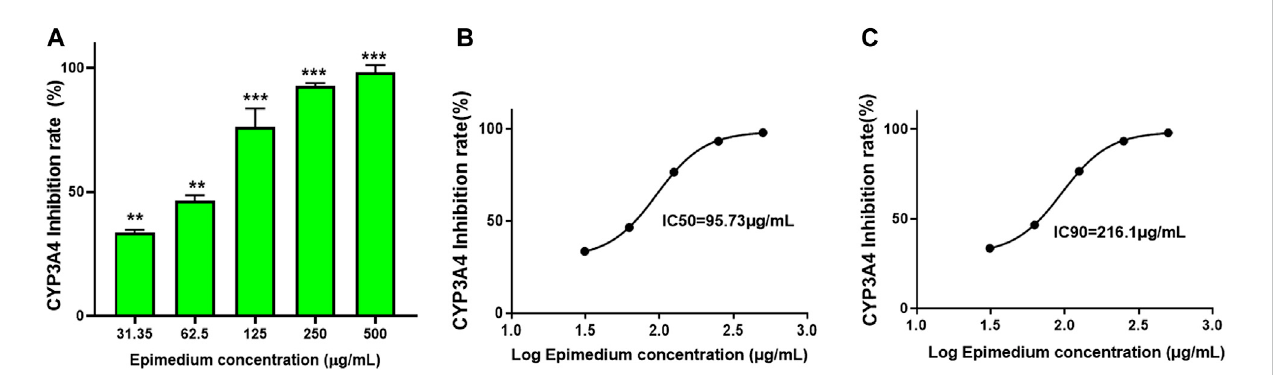
FIGURE 1 Epimedium inhibition of CYP3A4 activity: The inhibition of CYP3A4 was measured by commercially available Vivid assay kit as per manufacturers instruction. Epimedium showed dose-dependent suppression of CYP3A4 enzyme activity (A) . The IC 50 and IC 90 were calculated to be 95.73 pg/mL and 216.1 pg/mL respectively (B,C) . Data represents triplicate experiments and expressed as mean ± SD. np < 0.01; *** p < 0.001 vs. control.